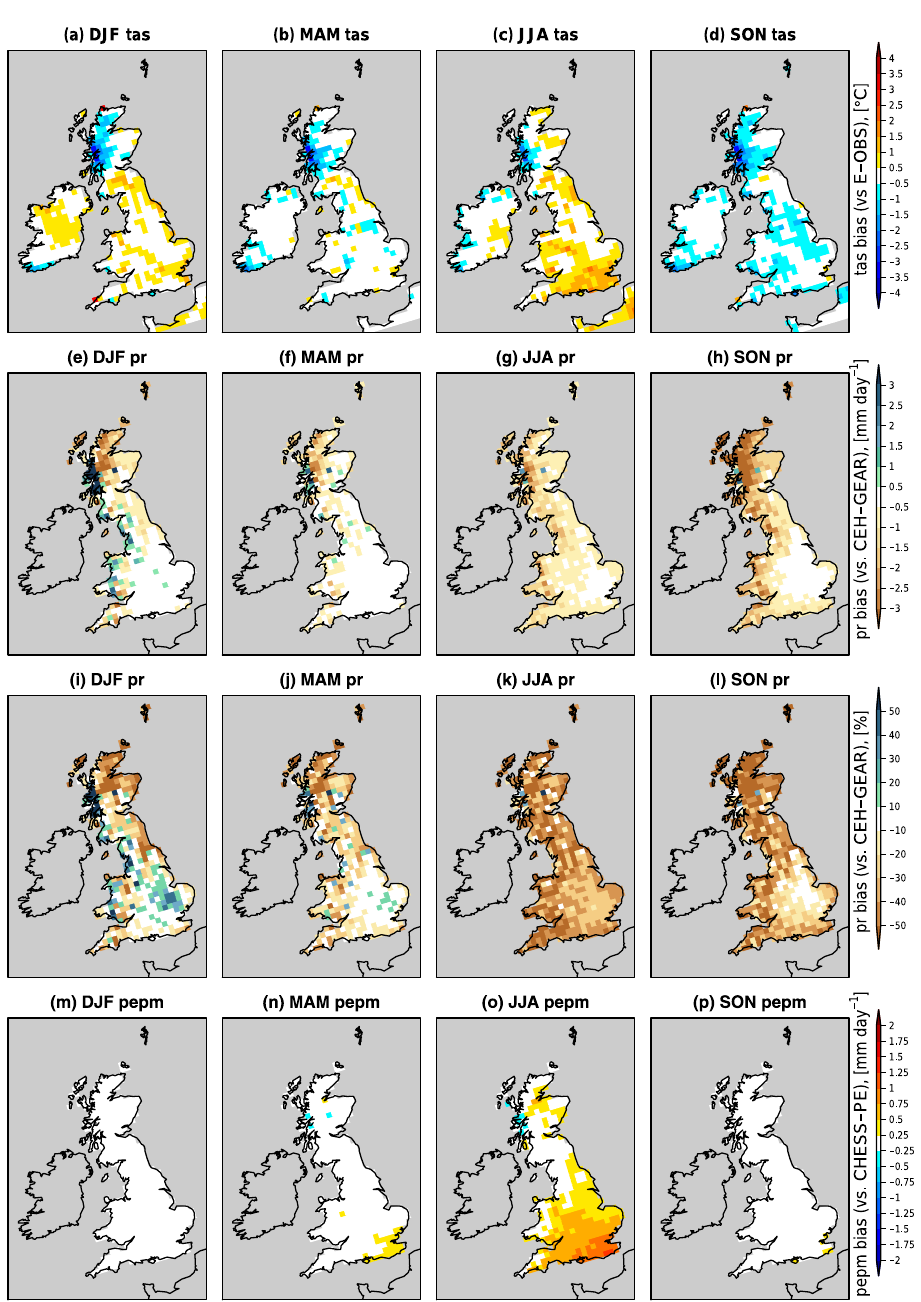
Figure 4. Seasonal biases in (a–d) mean surface air temperature, (e–h) precipitation in mmday − 1 , (i–l) precipitation in % and (m–p) E pot , for years 1961–2006. Each column is for a season as indicated in the